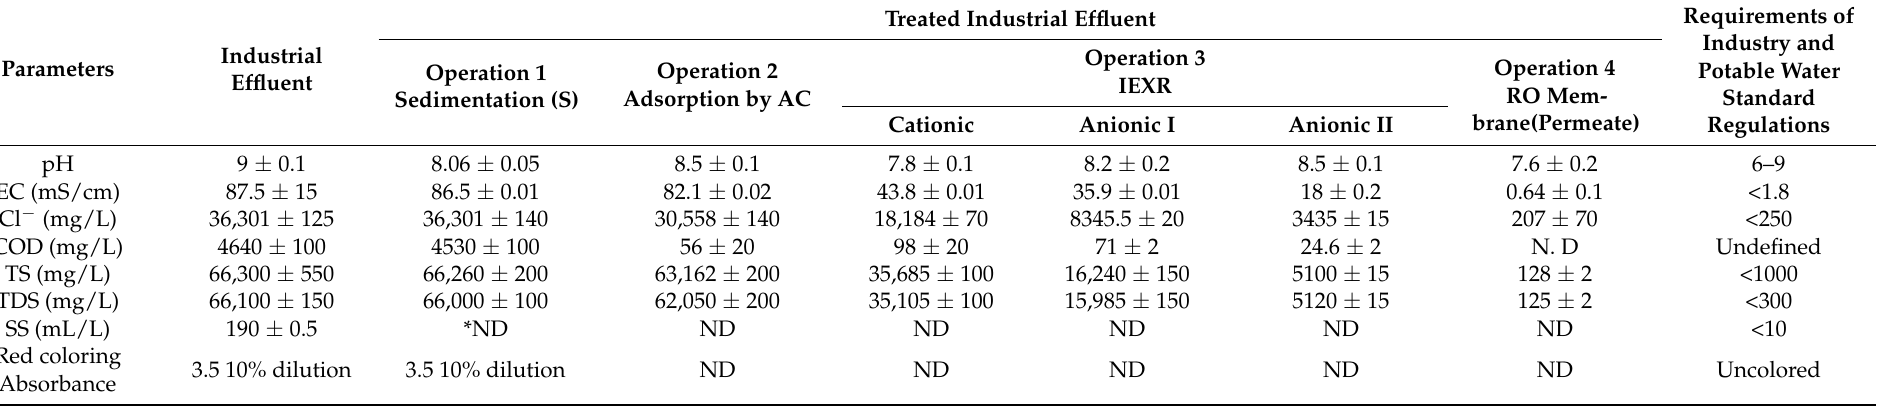
Table 2. Physicochemical characteristics of the effluent treated through the different unit operations of the treatment process of industrial